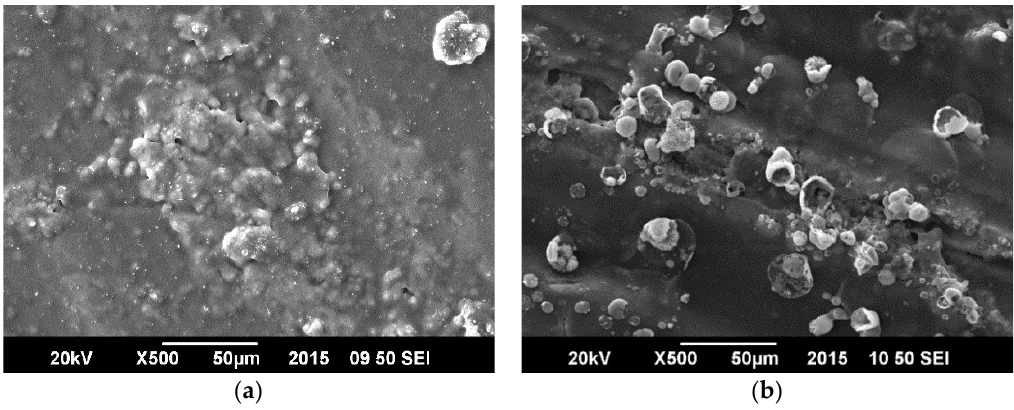
Figure 5. SEM micrographs of SAN/PANI/FLG coated samples in seawater. ( a ) Before corrosion test; ( b ) After corrosion test.